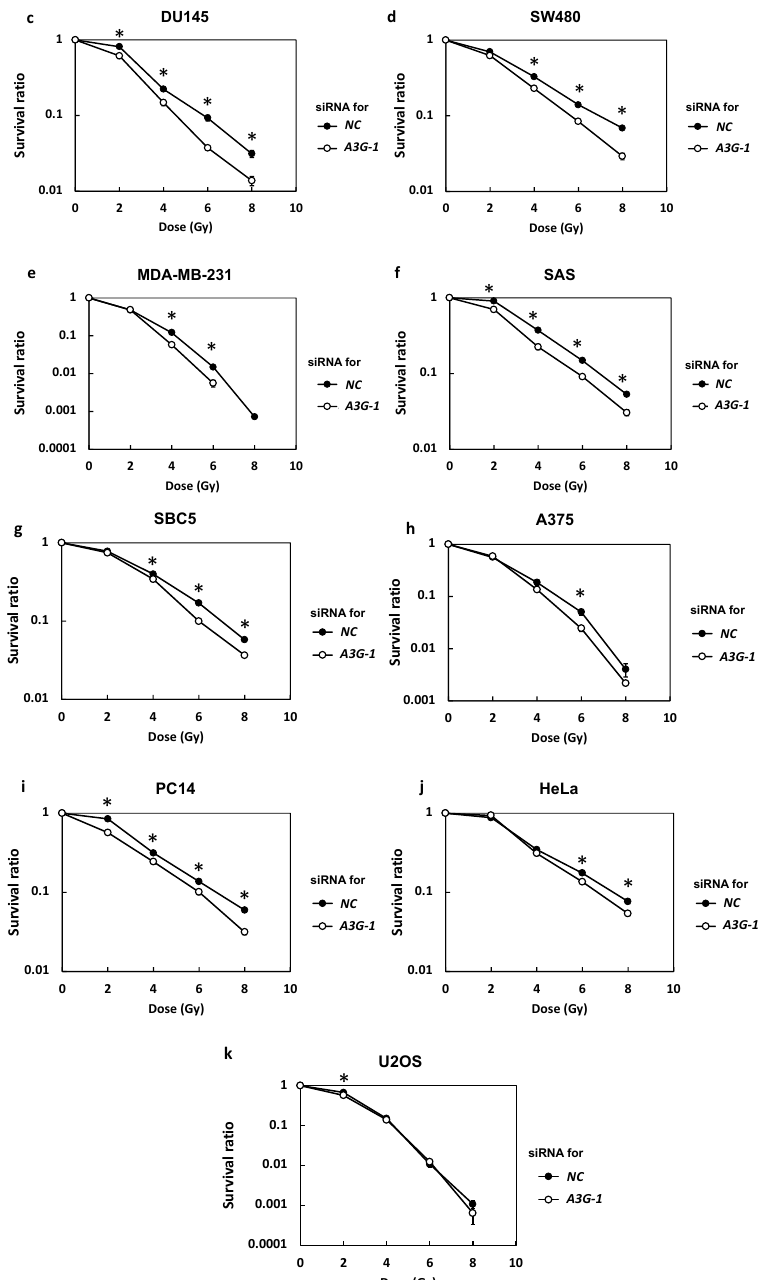
Figure 1. Negative screening of radiosensitization targets using an shRNA library. ( A ) Lung cancer A549 cells were infected with a lentiviral shRNA expression library and γ -irradiated at 4 Gy or mock-irradiated, and then cultured for seven days. Candidate genes involved in radiosensitization and radioresistance were identified by microarray analysis using barcode sequences as described in Materials and Methods. ( B ) a. The results of negative screening using pool1 and pool2. b. Classification of hit genes is shown separately for enhancing ionizing radiation (IR) effects and reducing IR effects. ( C ) Relative A3G mRNA expression levels and knockdown levels analyzed by real-time PCR analysis in 11 cancer cell lines. A3G expression in cancer cell lines were compared using a primer set that detects all main reported splicing variants (see Figure S1). A3G gene was knocked down with si A3G-1 , which targets the common exon sequence present in all main splicing variants. ( D ) a – k. Comparison of the effect of A3G knockdown on radiosensitization in 11 cancer cell lines from various cancer types analyzed after γ -irradiation by colony formation assay.